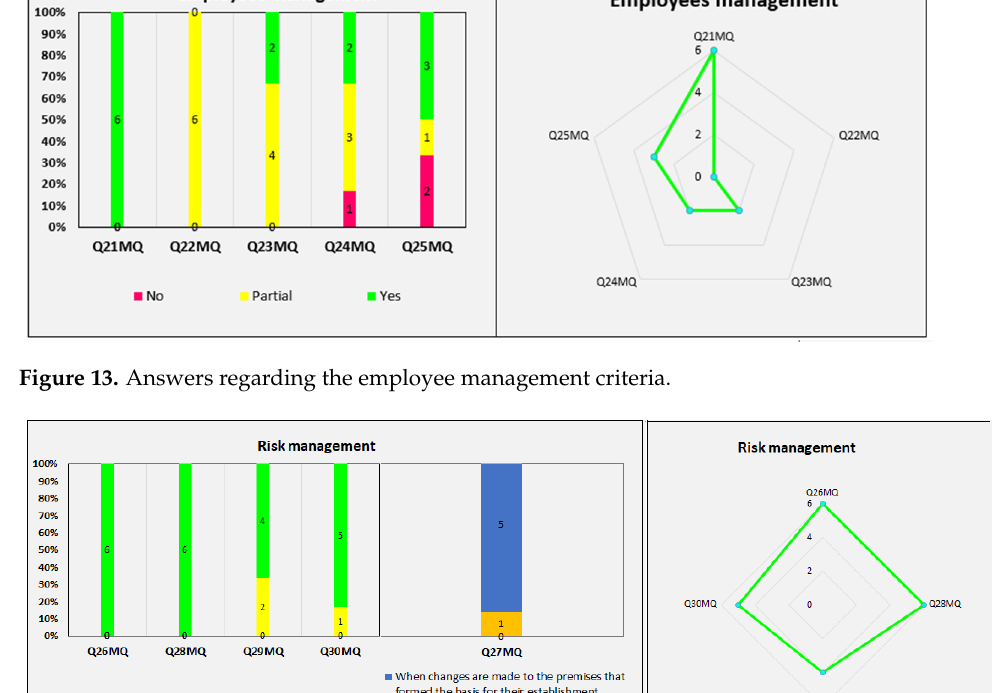
Figure 13. Answers regarding the employee management criteria.